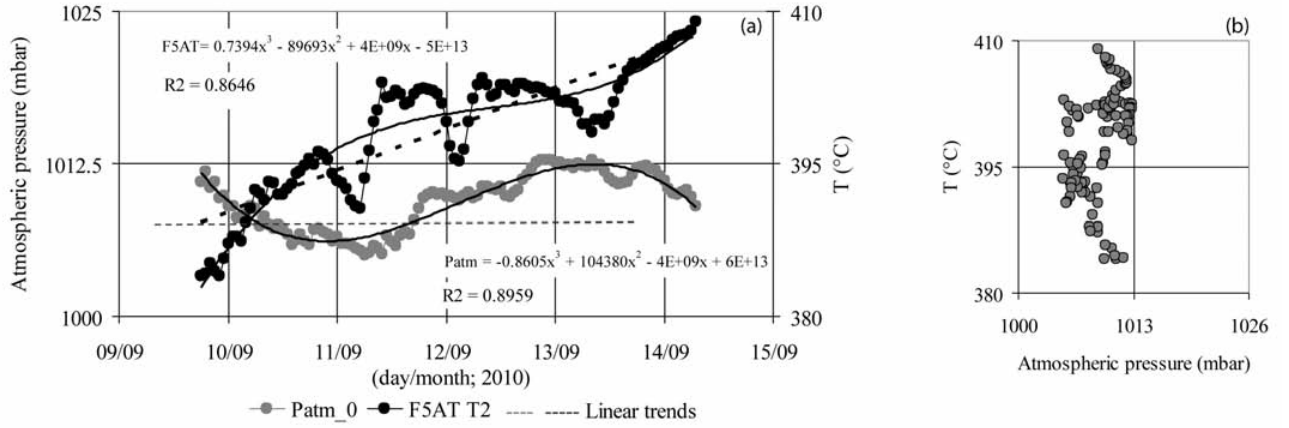
Figure 6. (a) Short-term variations recorded for atmospheric pressure and fumarole temperatures (September 9-15, 2010). The linear trends for both of the parameters are shown, as well as the best-fit polynomial curves of the third order, with the relative equations and regression coefficients. (b) Fumarole temperatures versus atmospheric pressures, using the data from